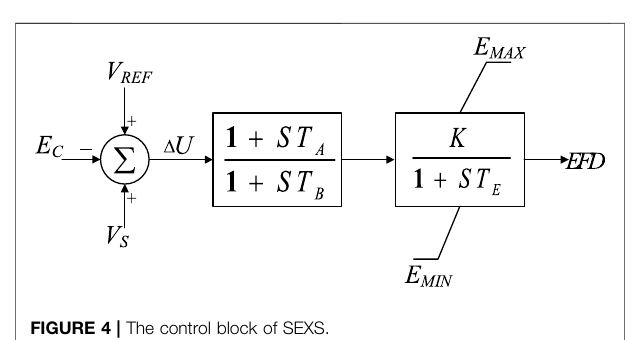
FIGURE 4 | The control block of